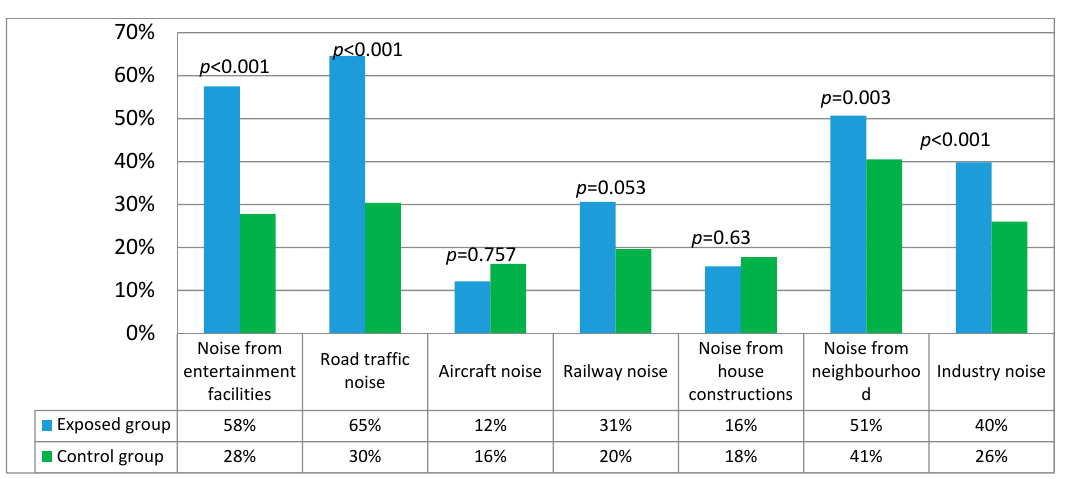
Figure 1. Comparison of noise annoyance from different sources between the exposed group to road traffic noise and the control group.